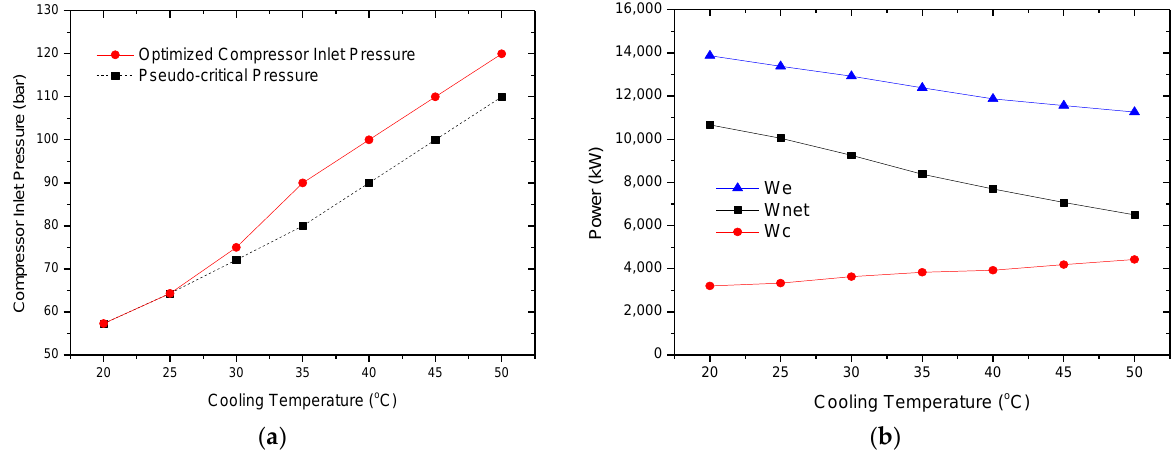
Figure 7. Optimal compression process of S-CO 2 power cycle for given cooling temperature: ( a ) optimal low-pressure side; ( b ) compression, expansion, and net work.